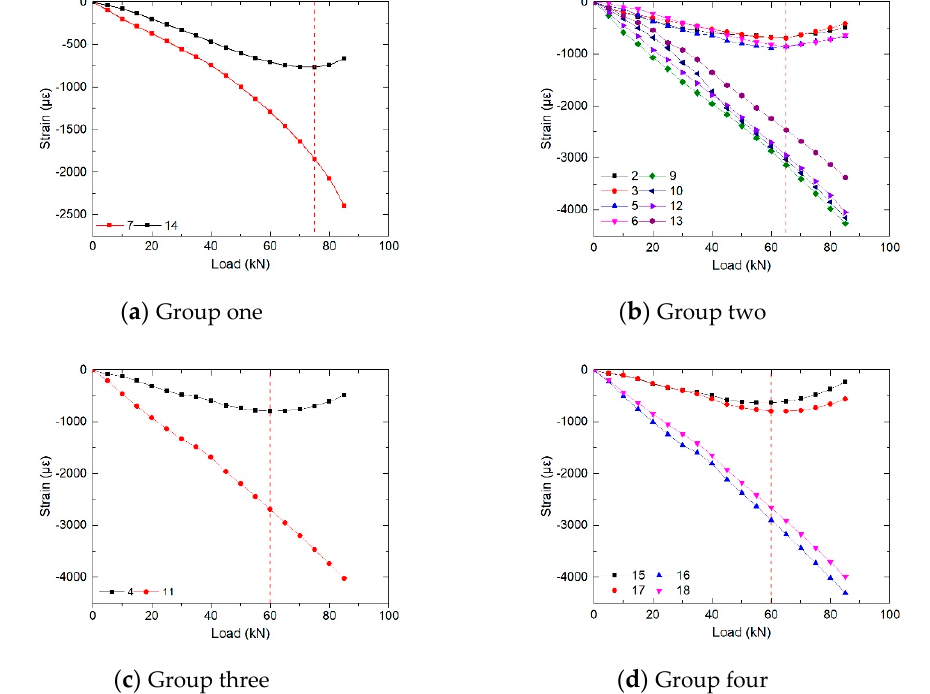
Figure 6. Typical strain-load curves of the third compressive sample with defective diameter 40 mm (CD40-3).